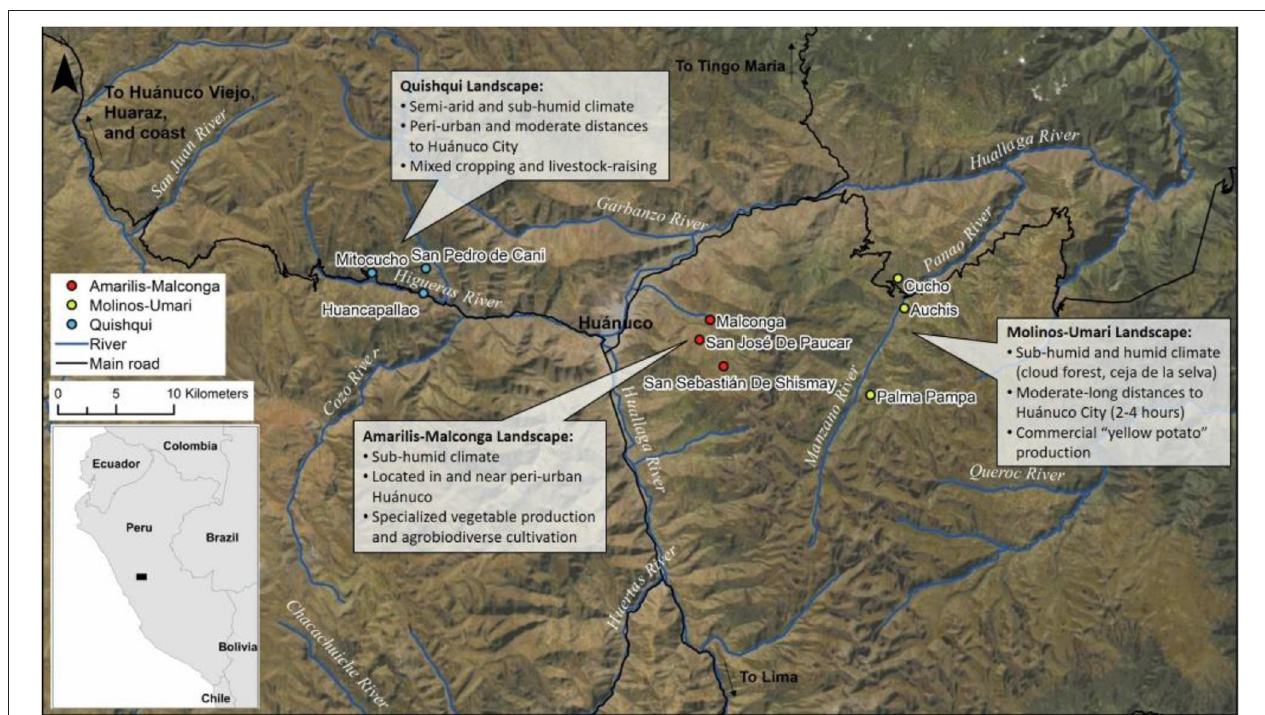
FIGURE 2 | Map of Huánuco study area in Central Peru, with examples of participating study communities in research-focus landscapes (Quishqui, Amarilis-Malconga, Molinos-Umari).